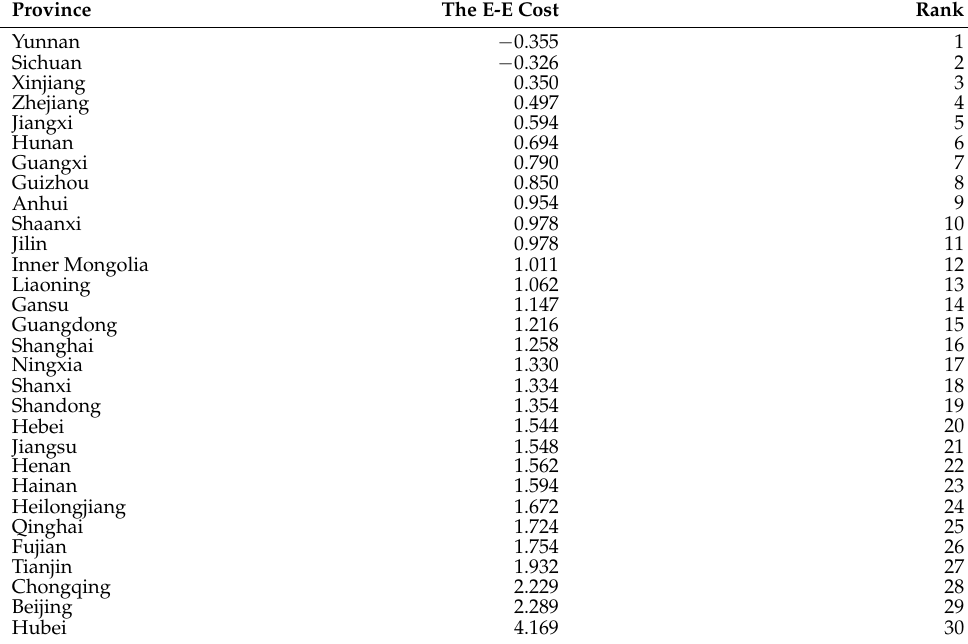
Table A13. The “E-E cost” rank of 30 provinces in China.